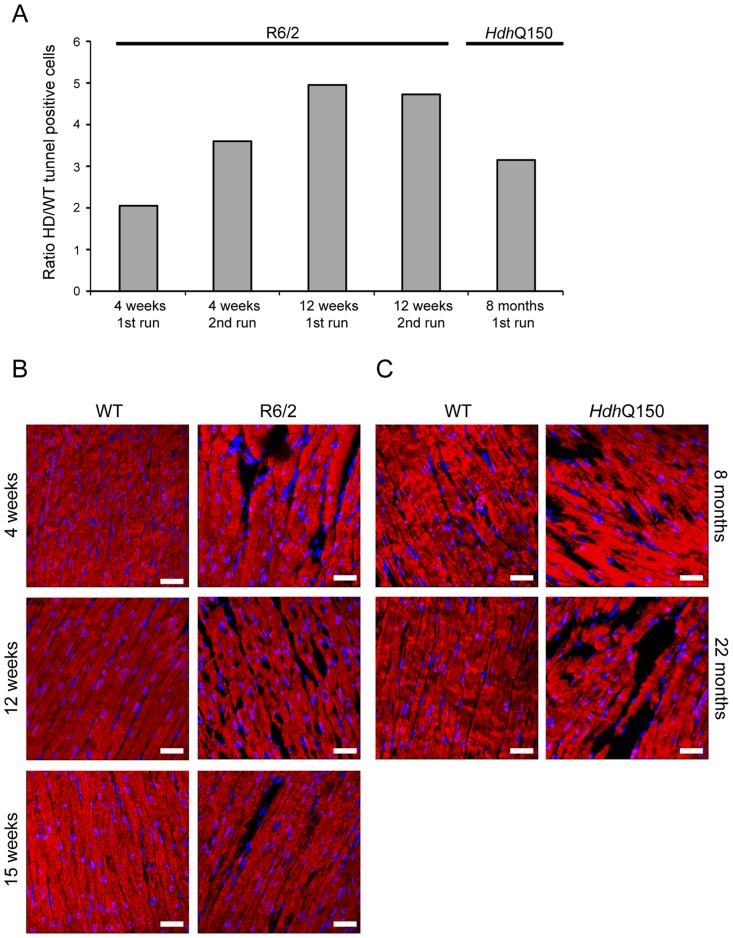
Ongoing cardiomyocyte death occurs through apoptosis in the hearts of HD mouse models.(A) TUNEL staining showed an increase of apoptotic activation in hearts from 4 and 12 weeks old R6/2 mice and 8 months old HdhQ150 mice. The TUNEL assay was performed on 3 longitude sections from 3 animals (WT and HD) at each time point (for each of two separate runs). The fold change of apoptotic nuclei scored in HD animals (R6/2 or HdhQ150) was normalized to their WT littermates. (B) Representative phalloidin staining (red) shows left ventricle myocyte degeneration and disarray in 4, 8 and 15 weeks old R6/2 mice. (C) Similar myocyte characteristics were found in the left ventricle myocytes from 8 and 22 months old HdhQ150 mice. Nuclei (blue) were visualized with DAPI.